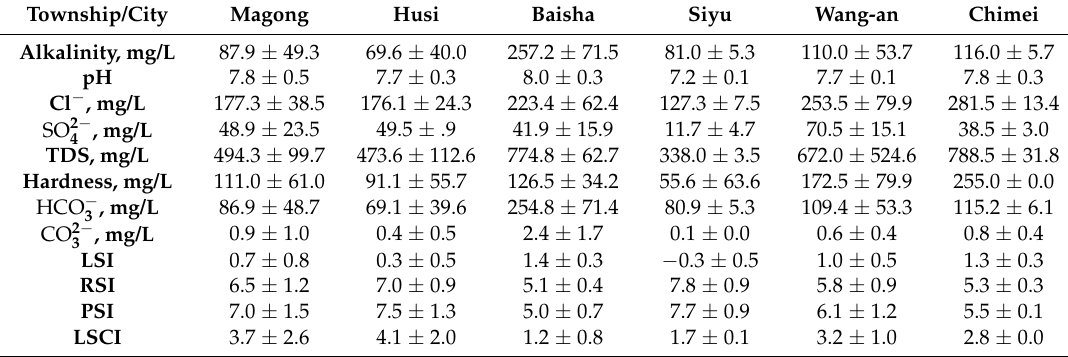
Table 3. Summary of chemical analysis and the water quality index for tap water in Penghu.